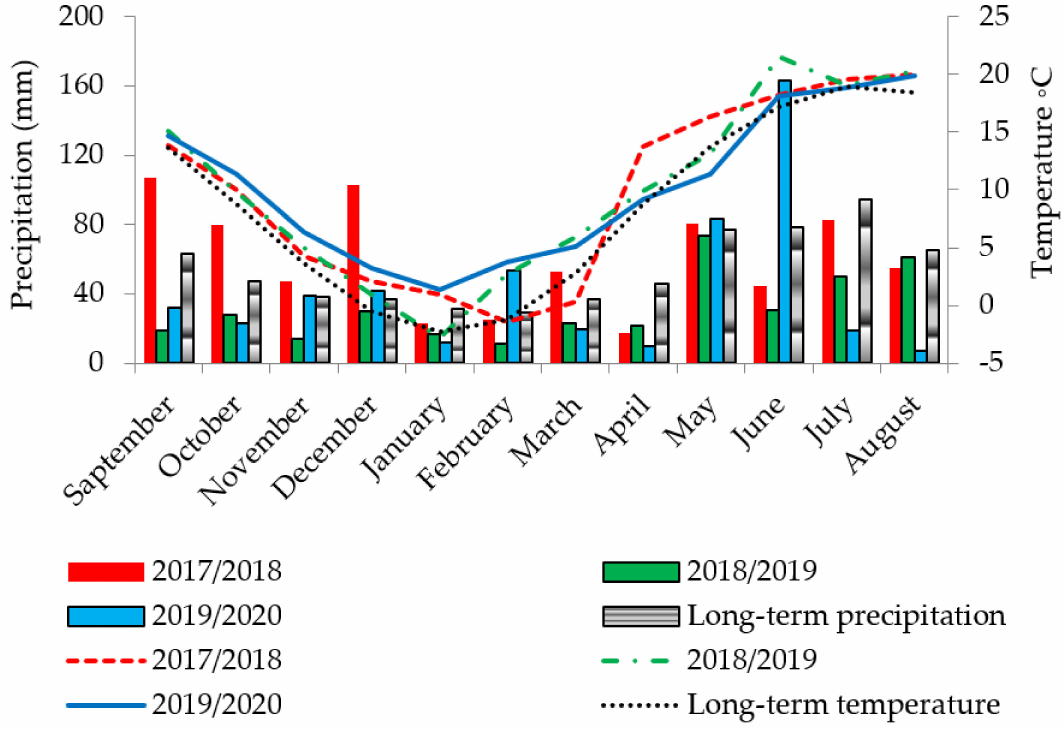
Table 1. Scheme of diversified fertilization of winter wheat (L·ha −1